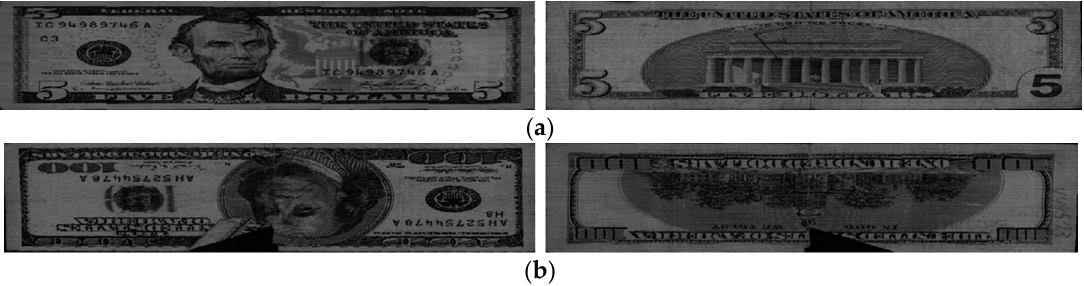
Figure 6. Example of banknote images in the USD database with fitness levels of ( a ) Fit and ( b ) Unfit.